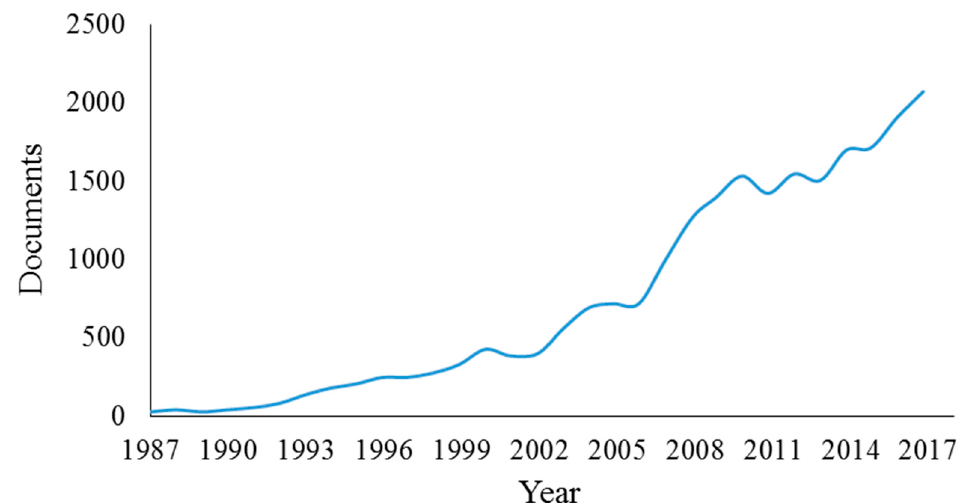
Figure 4. Analysis of the literature on soft computing in design, control, and development of rotating electrical machines from 1987–2017. Total of 30,382 document results. (Source: Scopus & Web of Science).